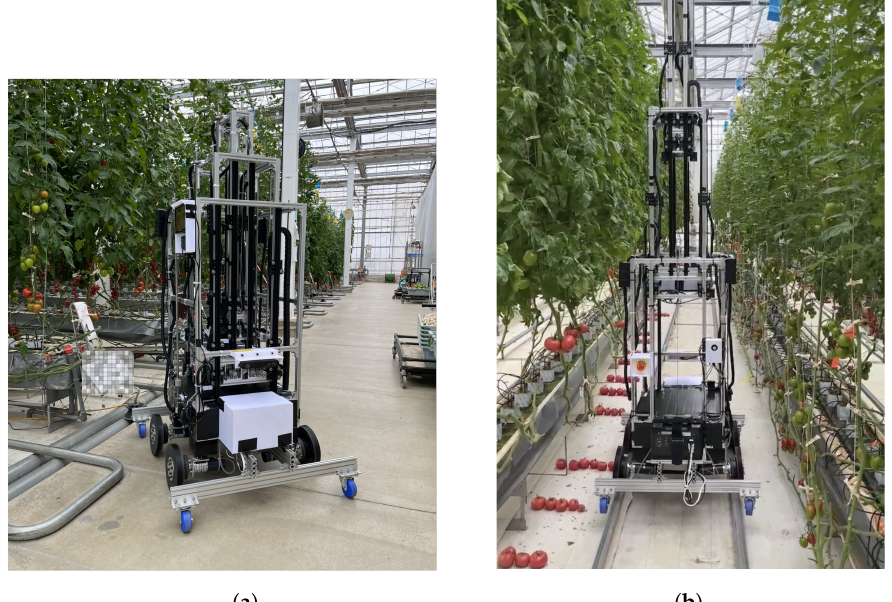
Figure 5. Proposed modular, extendable robot. The user is free to configure the robot to cope with the height of the tomato plants and can control costs as needed. ( a ) standard state; ( b ) extended state.